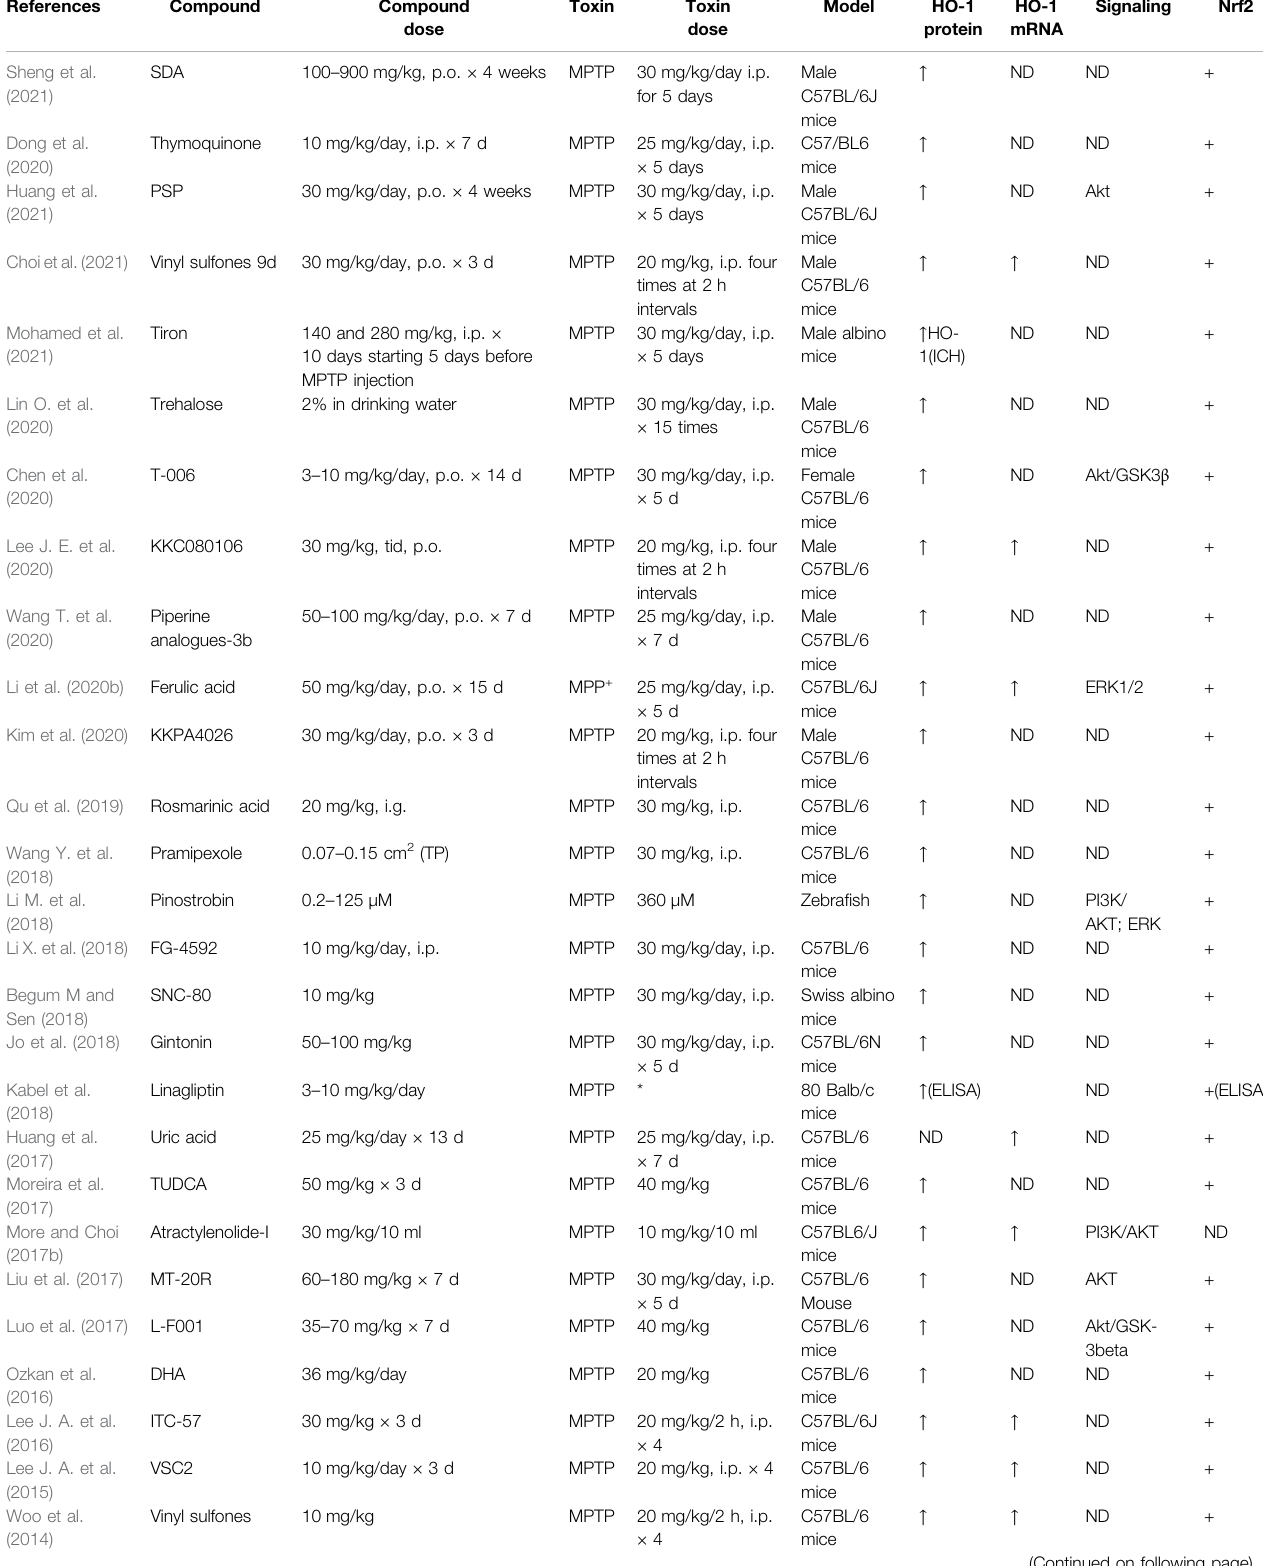
TABLE 9 | Summary of the experimental studies involving HO-1 inducer against MPTP-induced PD